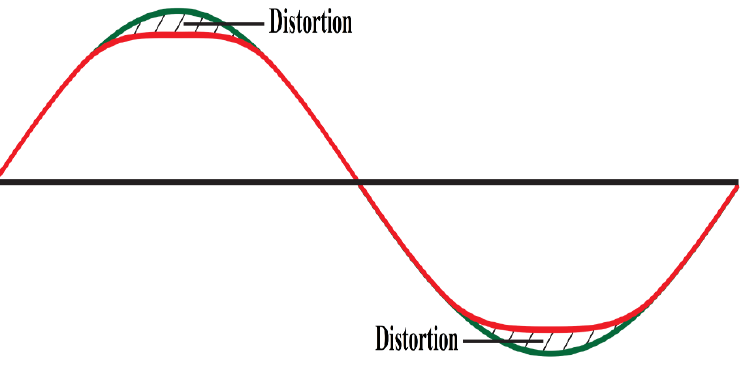
Figure 2. “Flat - topped” power -system voltage waveform [3]. Figure 2. “Flat-topped” power-system voltage waveform